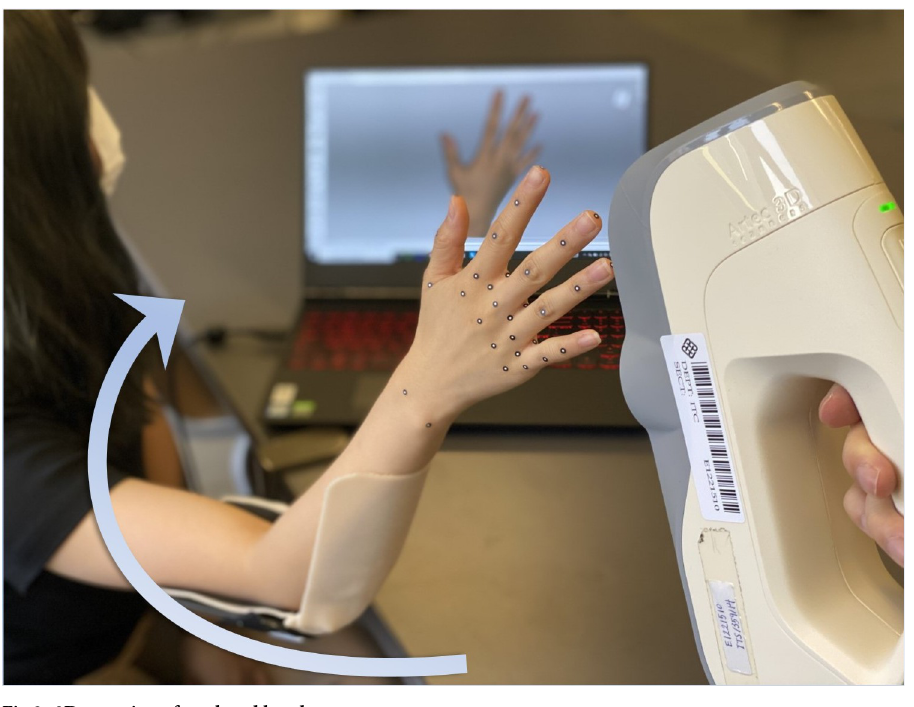
Fig 2. 3D scanning of a splayed hand